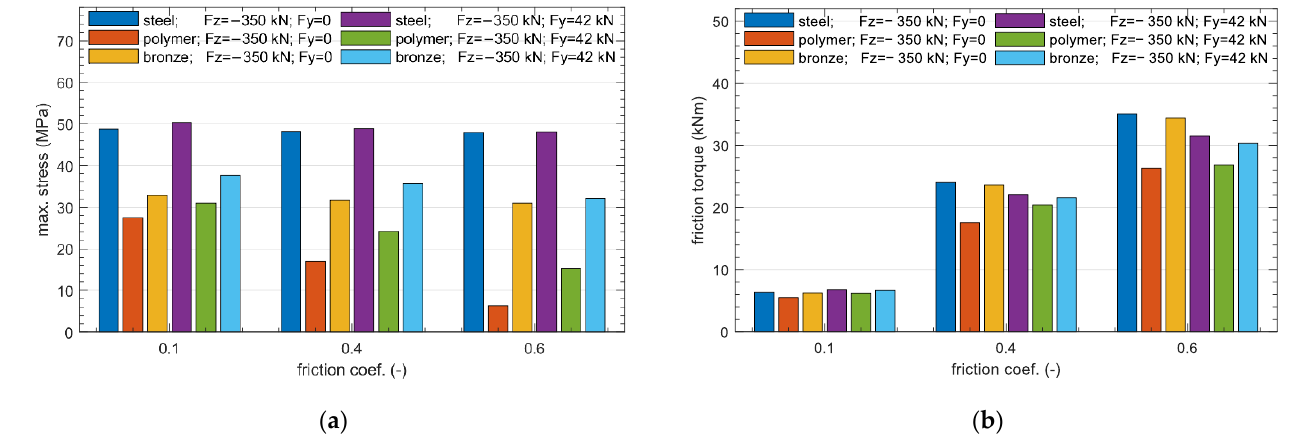
Figure 9. ( a ) Maximum equivalent stress values of the friction liner or pivot based on the Huber-Mises-Hencky hypothesis, ( b ) Values of friction torque in the centre bowl as a function of friction coefficient, type of material and lateral force value.